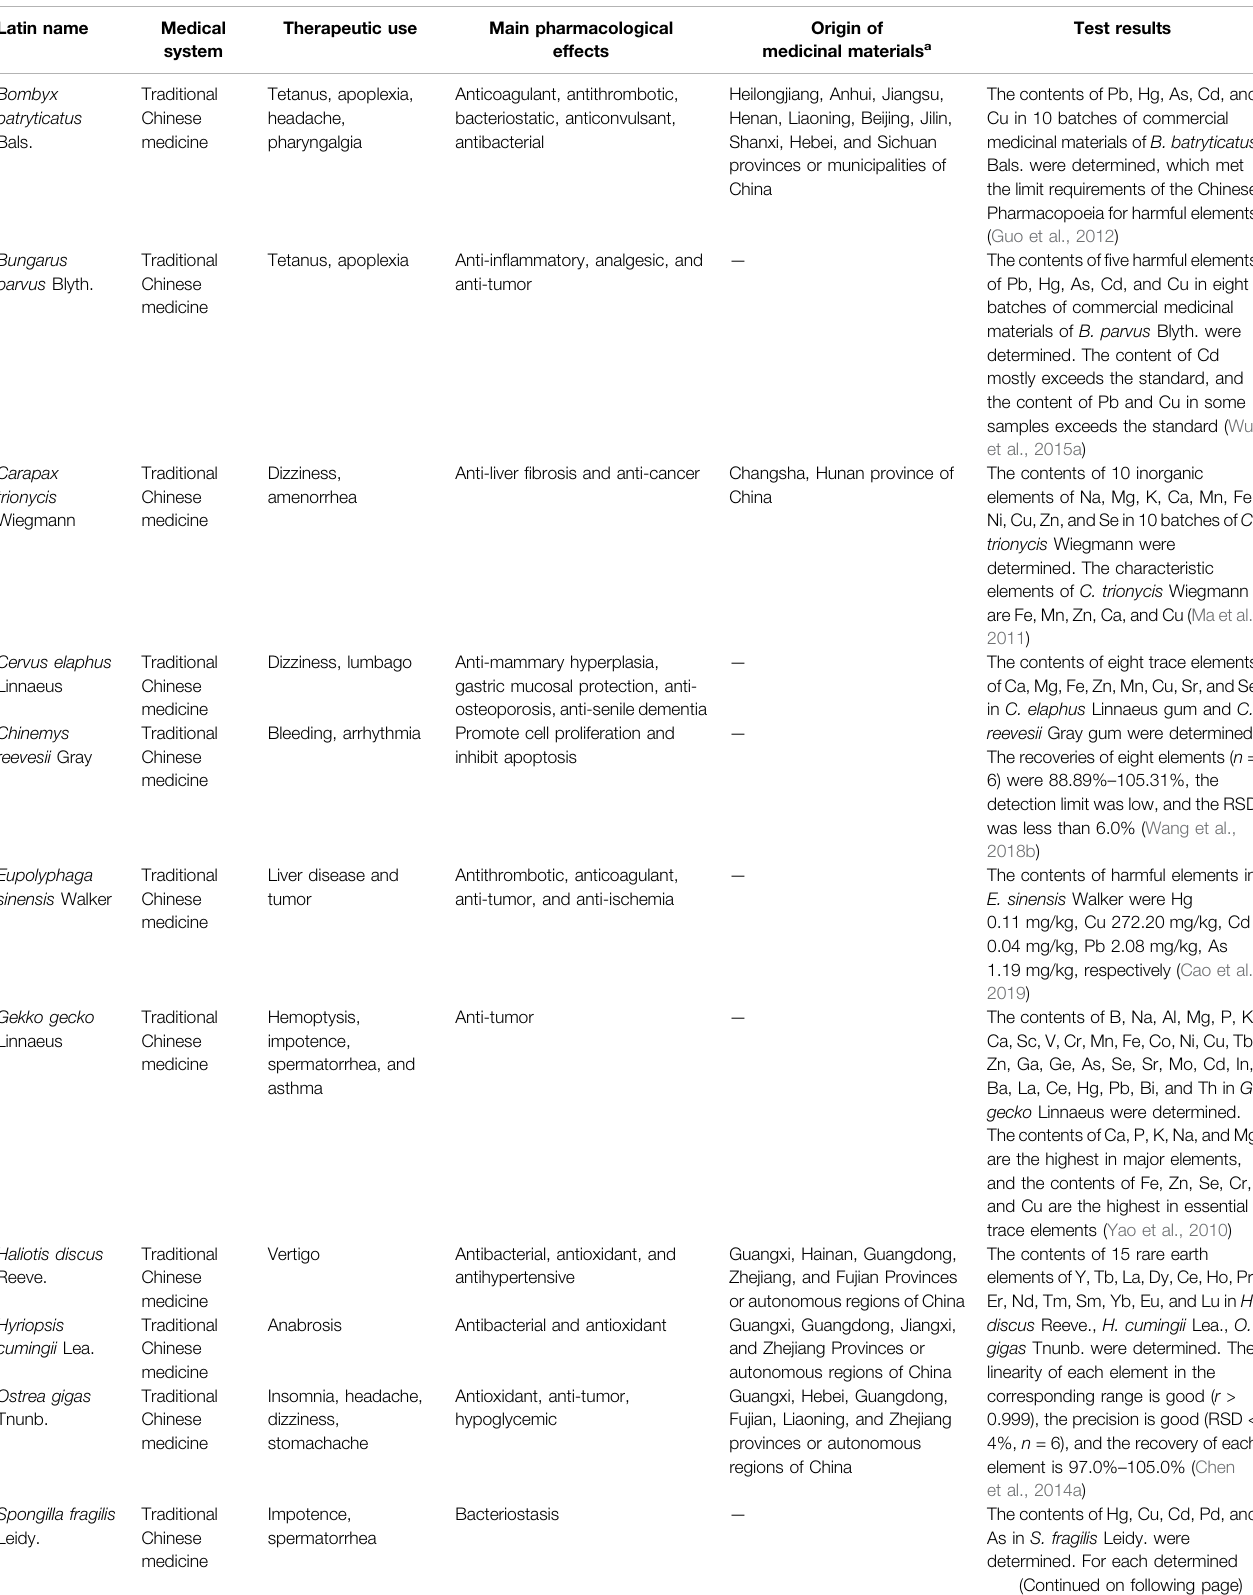
TABLE 8 | Application of ICP-MS in the determination of heavy metal elements in medicinal materials derived from animals. Latin